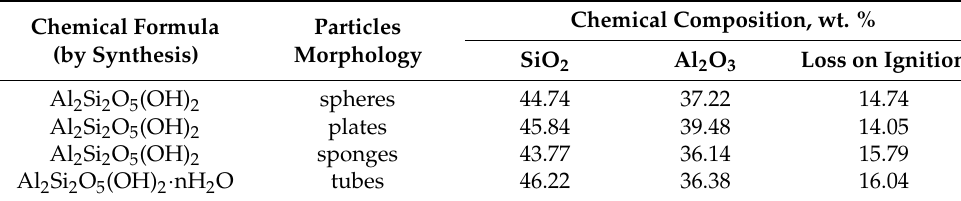
Table 2. The results of a chemical analysis of the